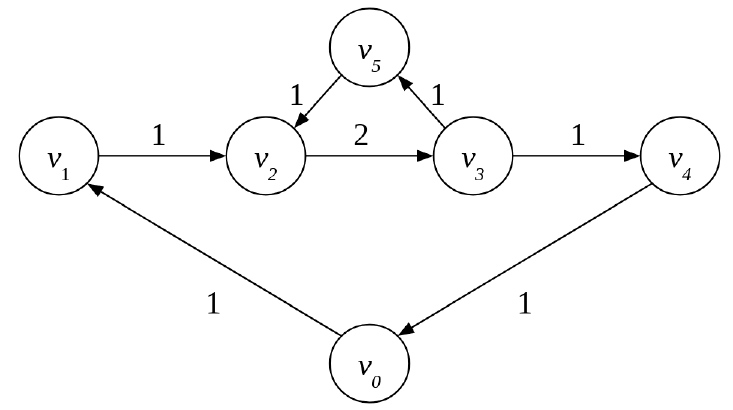
Figure 7. Payment system with a chain and a